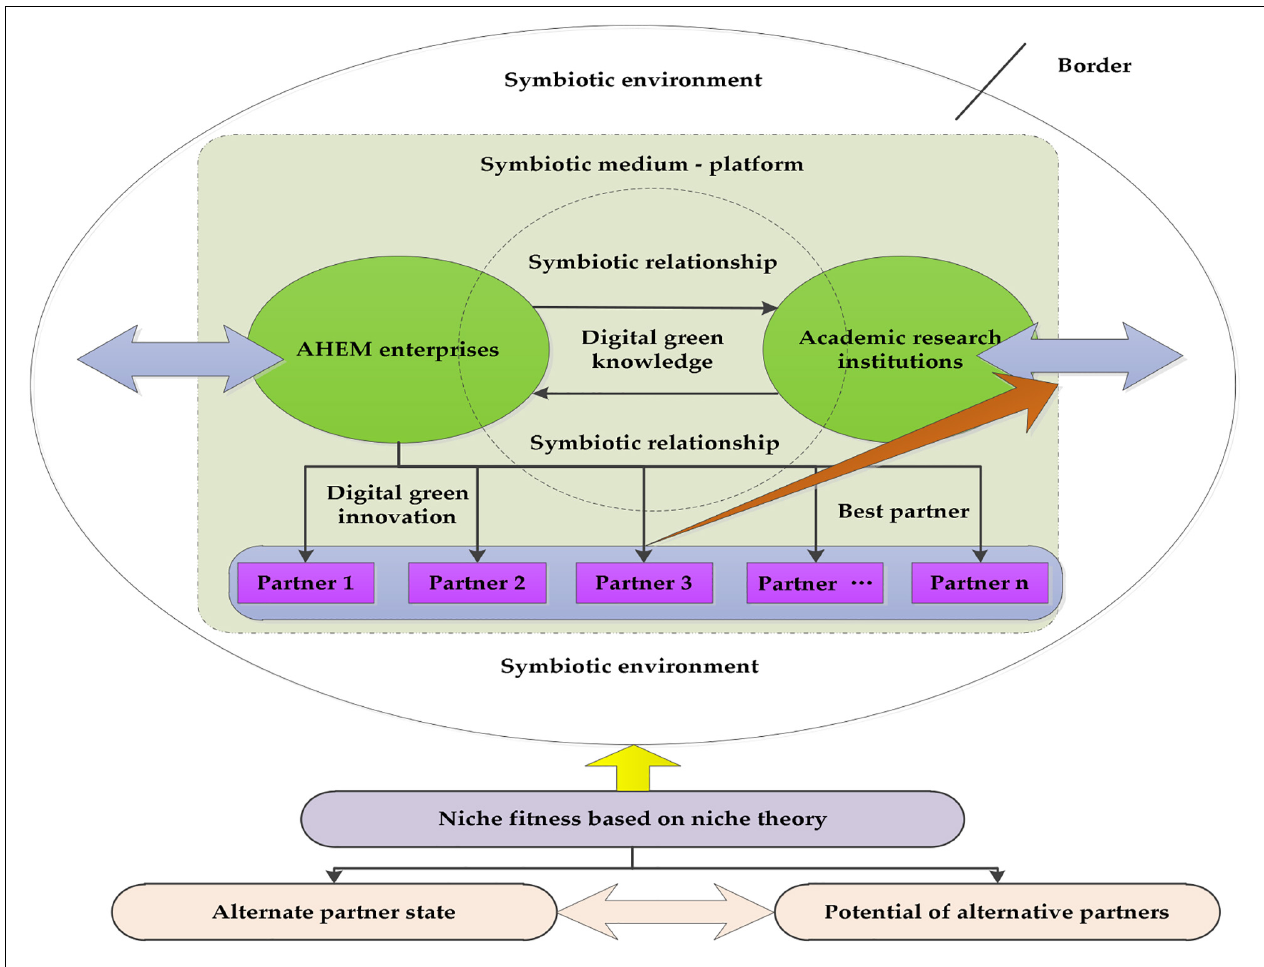
FIGURE 1 | A theoretical model of DGI partner